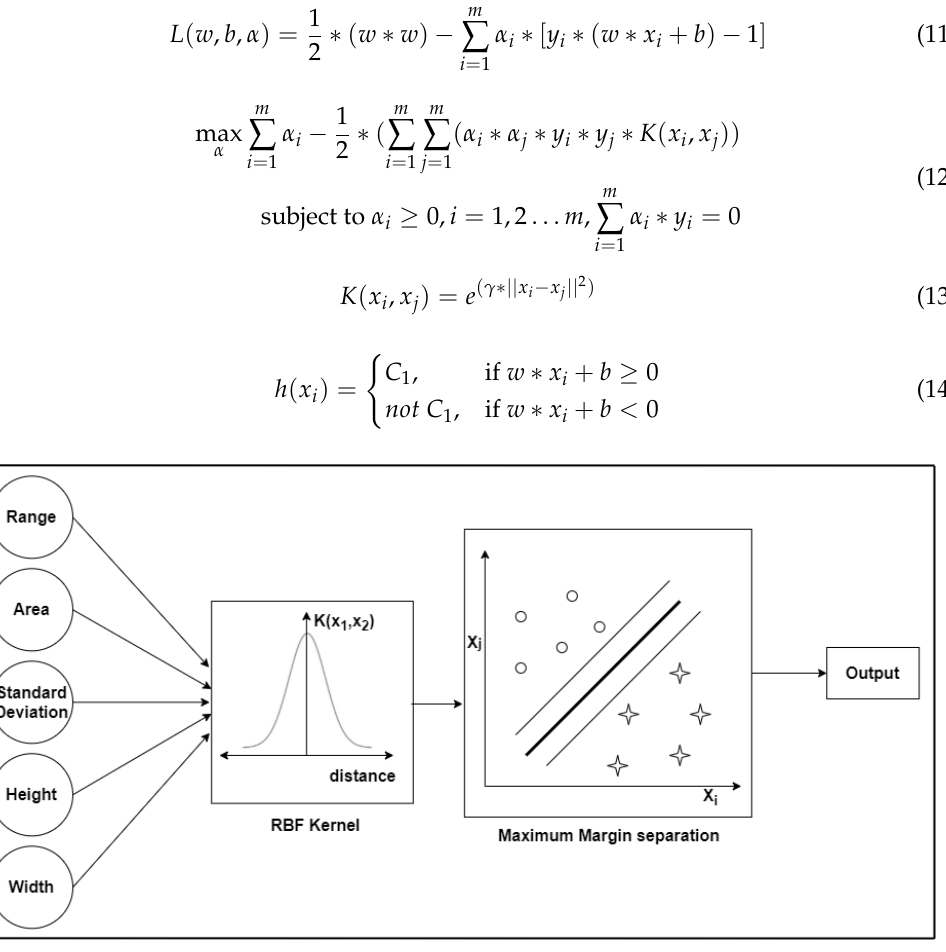
Figure 14. Support Vector Machine Model.